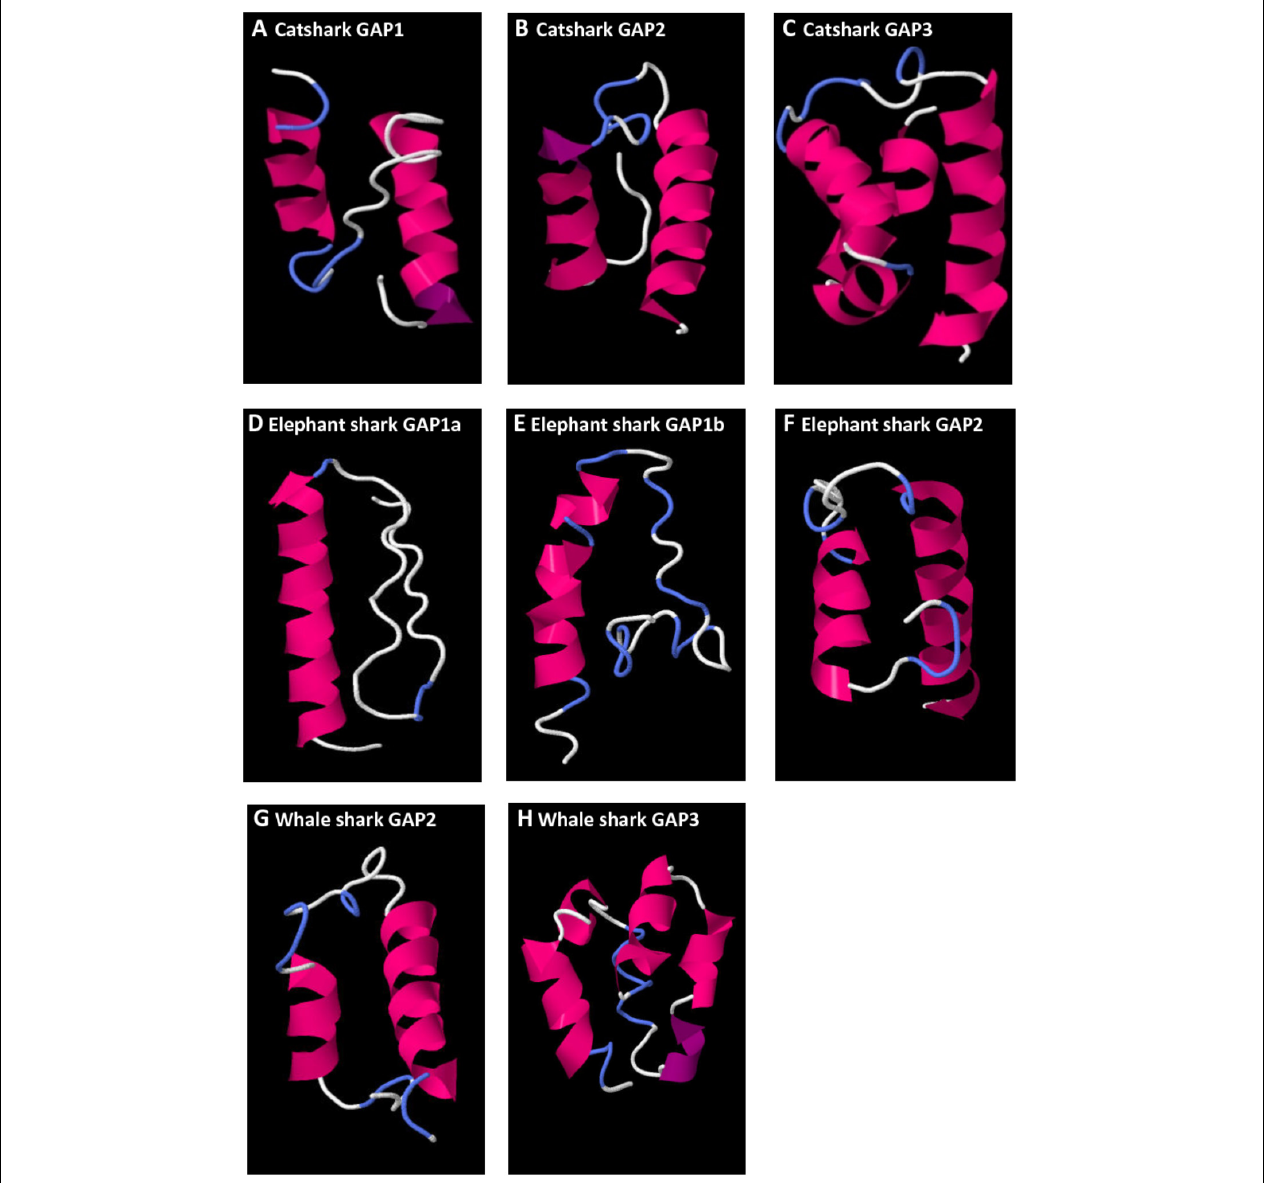
FIGURE 8 | Predicted 3D structure of catshark GAP1 (A) , GAP2 (B), and GAP3 (C) , elephant shark GAP1a (D) , GAP1b (E) , and GAP2 (F) , whale shark GAP2 (G) and GAP3 (H) . Models predicted in I-TASSER server with a C-score between 2 and 4 were presented. In all the models, the C-terminal is oriented toward the right. In pink appears α -helix, in violet 3 10 -helix, in white loops, and in blue β